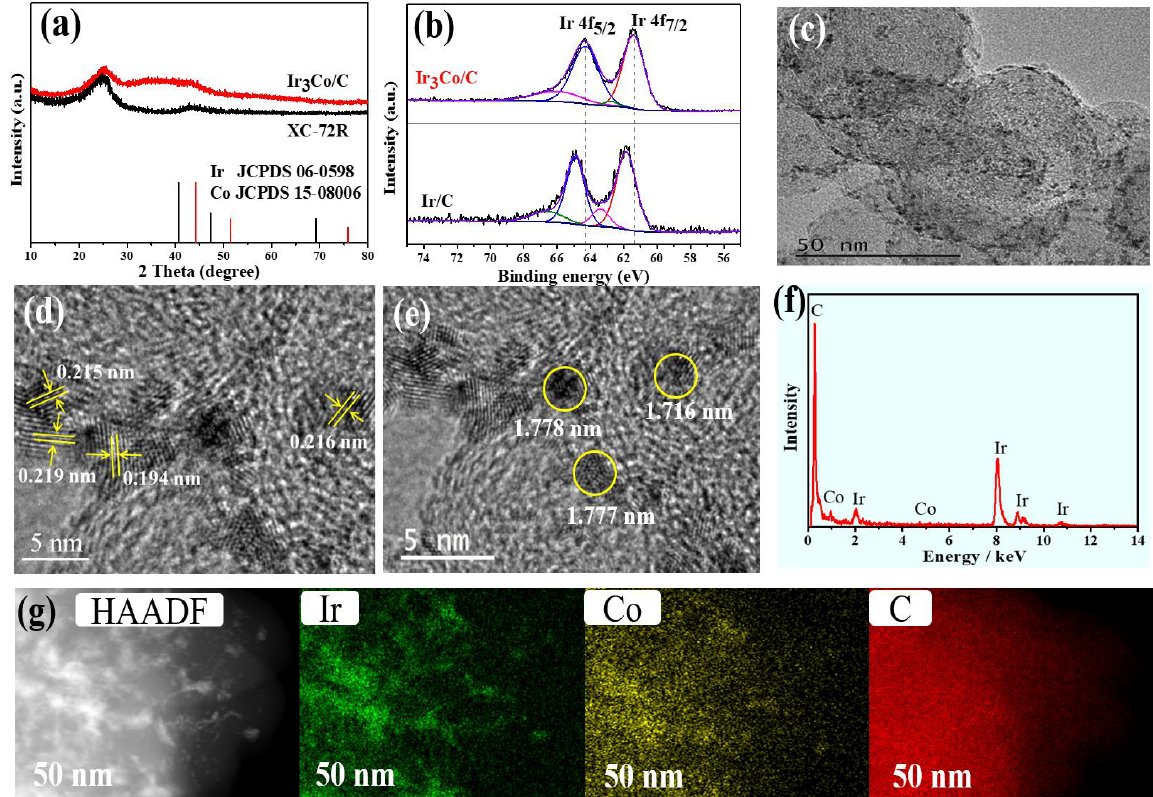
Figure 1. ( a ) XRD characterizations of Ir 3 Co/C and XC-72R. ( b ) XPS images of Ir 3 Co/C and Ir/C. ( c ) TEM image and ( d , e ) HRTEM diagram of Ir 3 Co/C. ( f ) EDS spectrum. ( g ) HAADF-STEM image of Ir 3 Co/C, from left to right are STEM-EDS mappings of Ir, Co, and C.